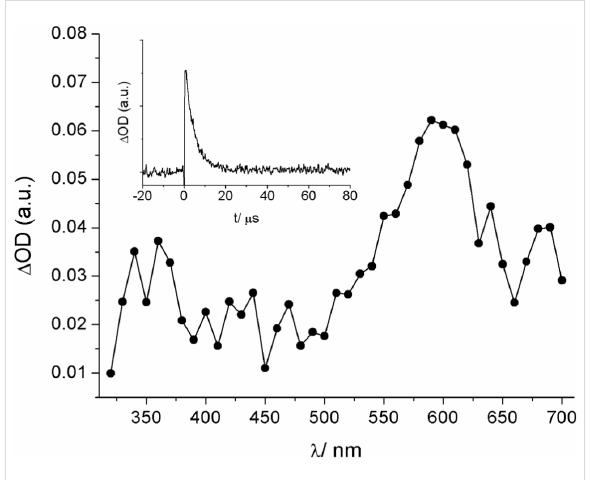
Figure 3: Transient absorption spectrum (600 ns delay) of dye 17 in nitrogen-purged acetonitrile on excitation at 308 nm. The inset shows the corresponding kinetics at 600